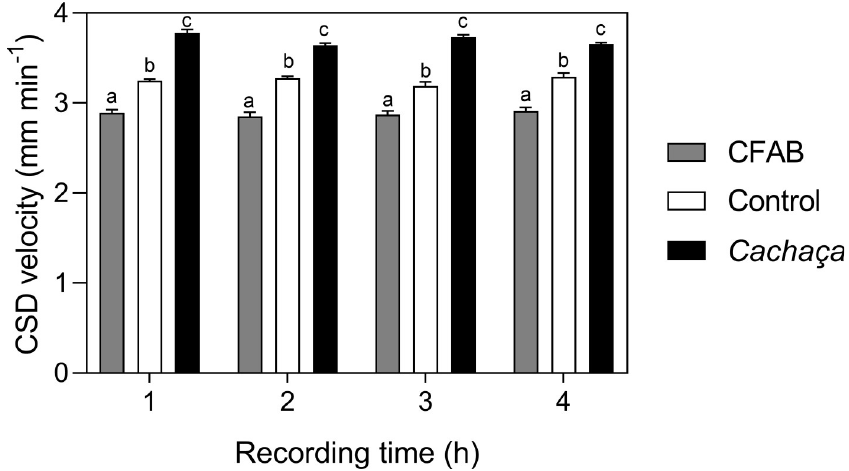
Fig 2. Electrophysiological recordings during cortical spreading depression effect of the alcohol consumption (CFAB, cachaça and only water) on cortical spreading depression propagation velocities in young-adult rats.